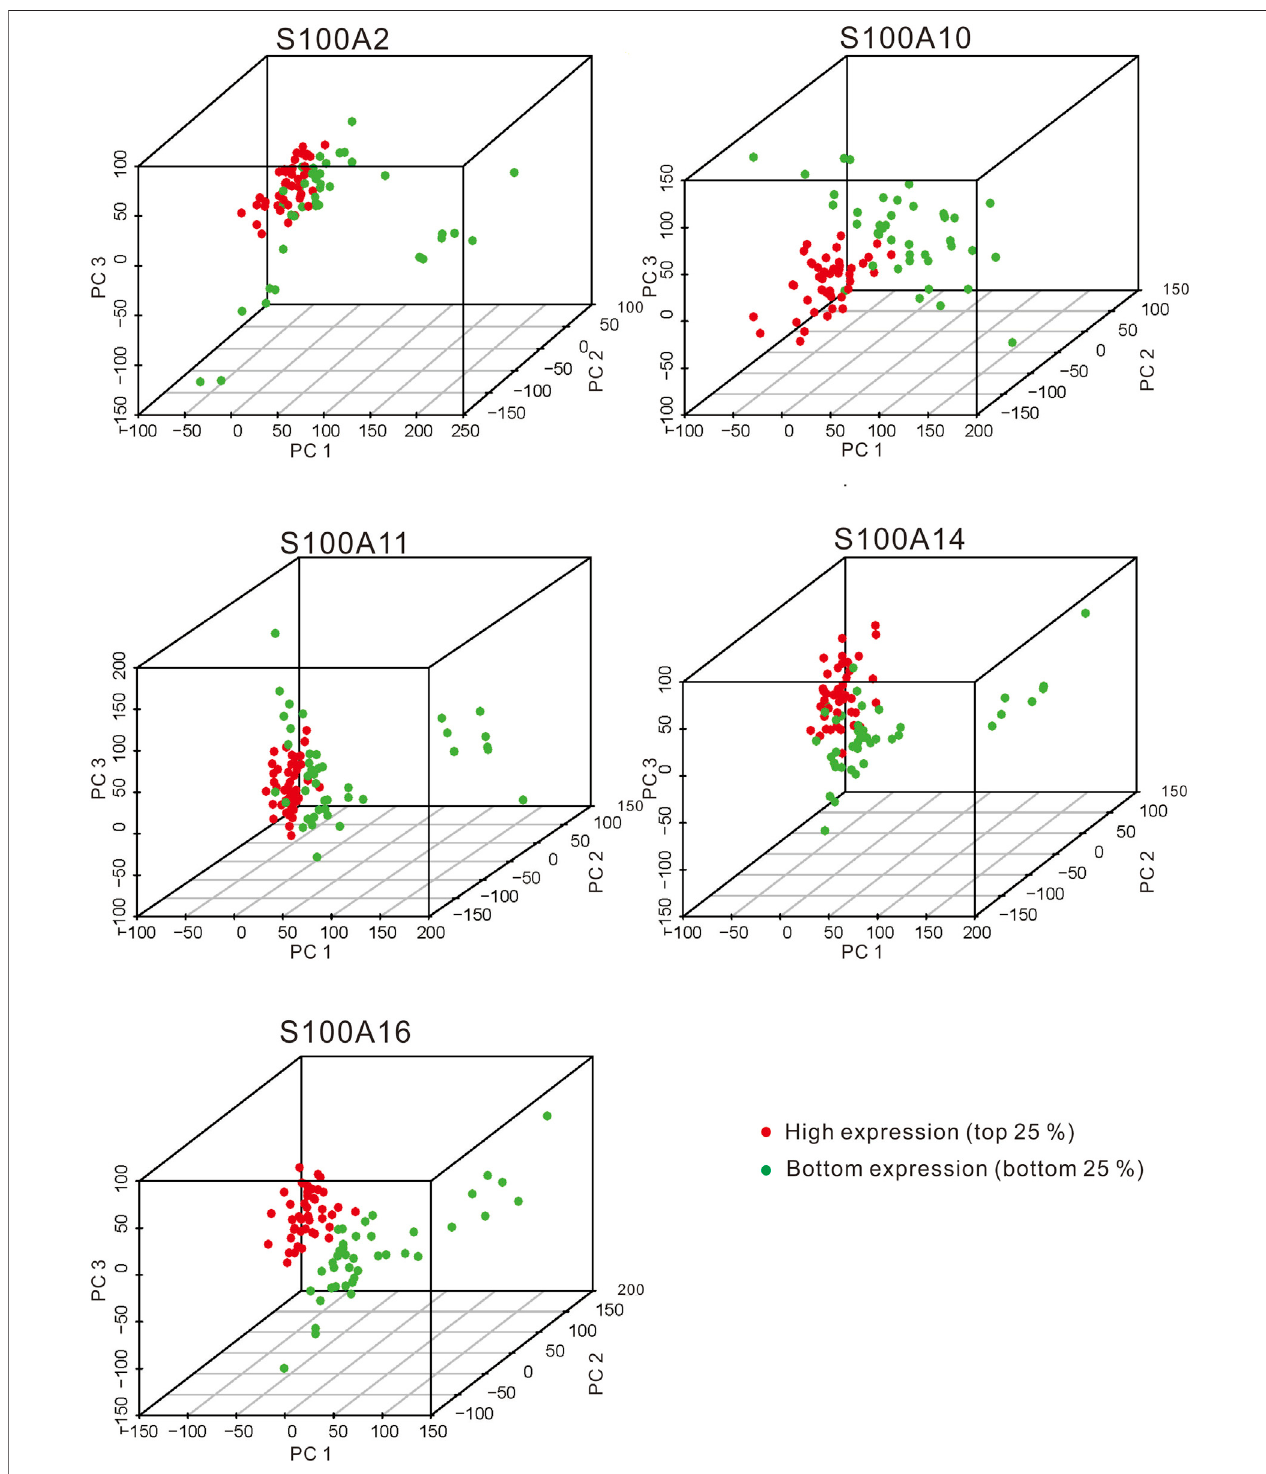
FIGURE 12 | The PCA plots showed the genes in samples with signi fi cant S100 gene high expression (top 25%) and low expression (bottom 25%) samples (calculated data from TCGA-PAAD, n (cid:1) 178). The red dot and green dot indicate the smaples with the high expression of the signi fi cant S100 genes (top 25 percentile) and the low expression (bottom 25 percentile) samples,